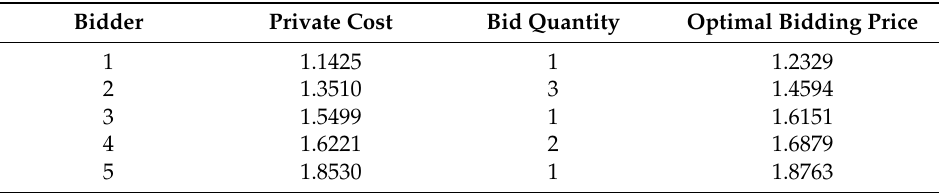
Table 2. Bidding results for a case study.